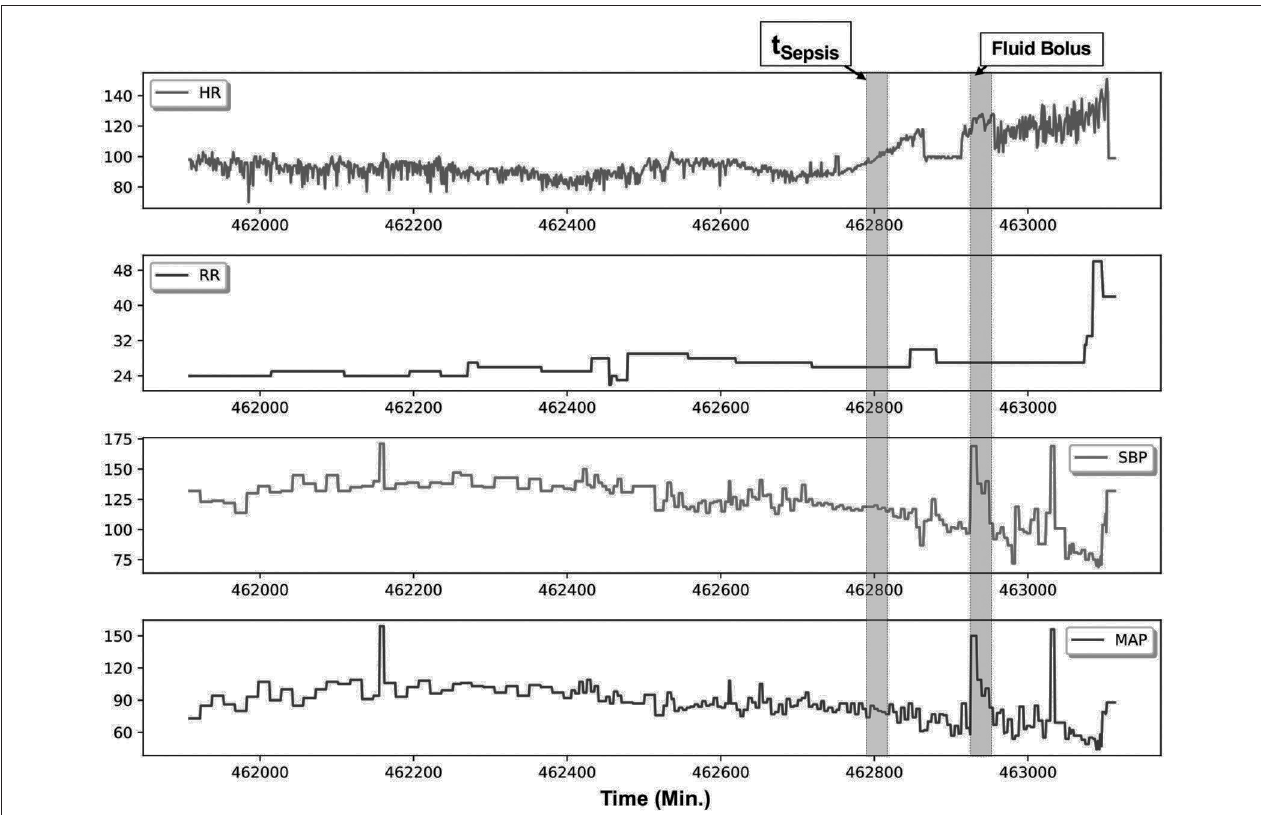
FIGURE 2 | An example patient with sepsis is illustrated in this figure; continuous physiological data were captured over an 18-h post-transplantation period. The patient met Sepsis-3 criteria (t Sepsis ) 13h post transplantation (retrospectively identified), and fluid resuscitation (fluid bolus) was initiated 1.5h thereafter. Several elements are of note within this patient, namely, in the preceding hours before meeting criteria, heart rate (HR) variability is noticeably reduced, accompanied by increased dynamics in the systolic blood pressure (SBP) and mean femoral artery blood pressure (MAP) data streams.